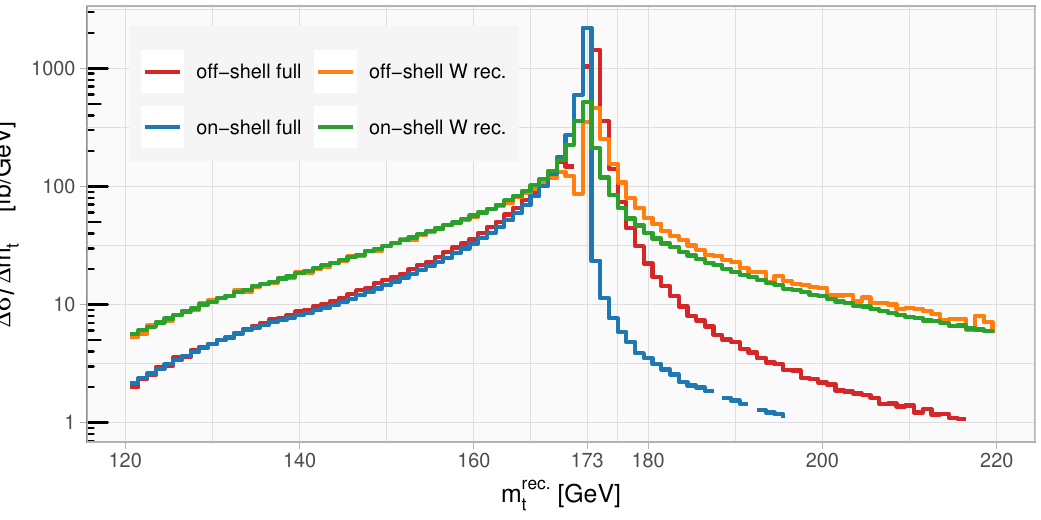
Figure 4. Reconstructed top-quark mass distribution for an on-shell and o(cid:11)-shell top quark at NLO . The full result denotes reconstruction through the full W -boson and b -jet four vectors. The \W rec." lines denote the reconstruction of the neutrino’s longitudinal